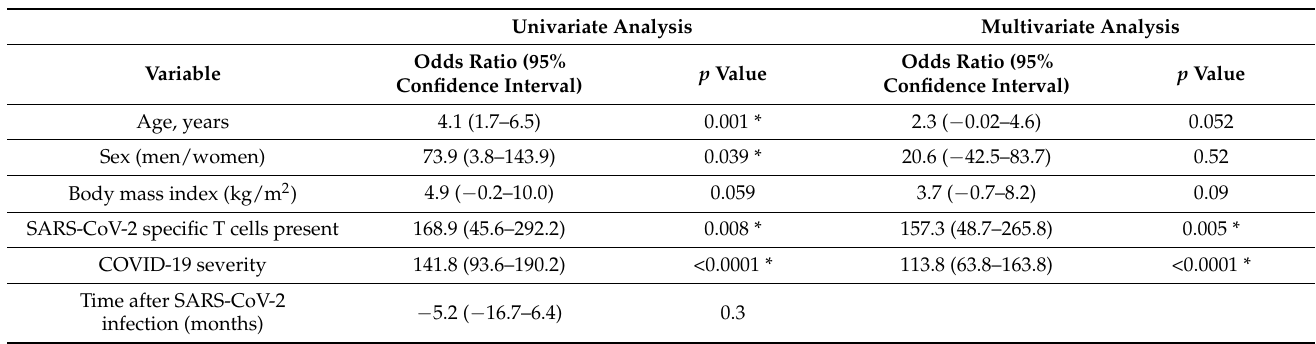
Table 6. Univariate analysis and multivariate analysis of factors associated with SARS-CoV-2 specific anti S protein IgG titer levels. * significant.